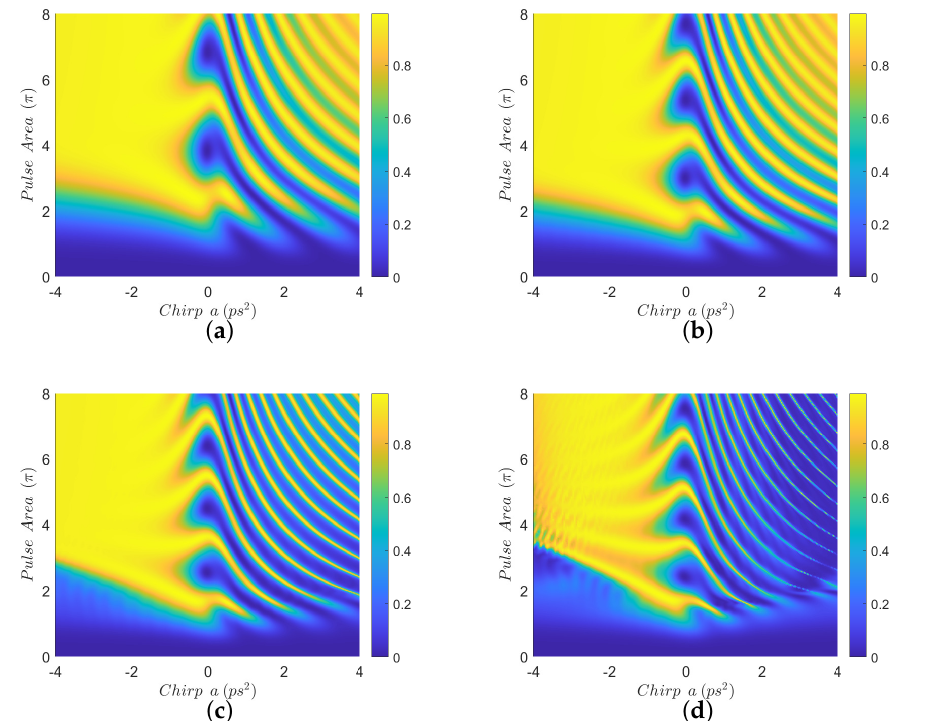
Figure 6. Contour diagrams for the biexciton population at the final time, as function of the pulse area and the chirp parameter a of the applied Gaussian pulse, with biexciton energy shift E b = 2.5 meV and four different interparticle distances: ( a ) R = 100 nm, ( b ) R = 15 nm, ( c ) R = 12 nm, and ( d ) R = 11